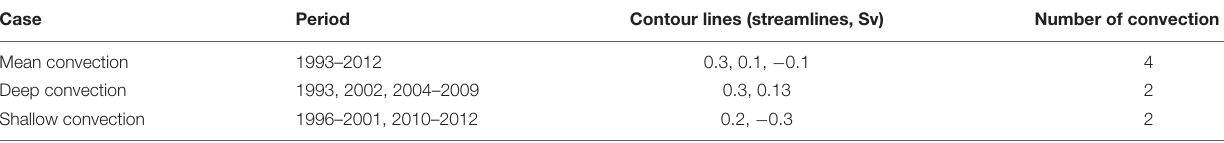
TABLE 2 | Turnover time ( tot s ) scenarios for the mean, deep, and shallow convection cases in the ES MOC. Case